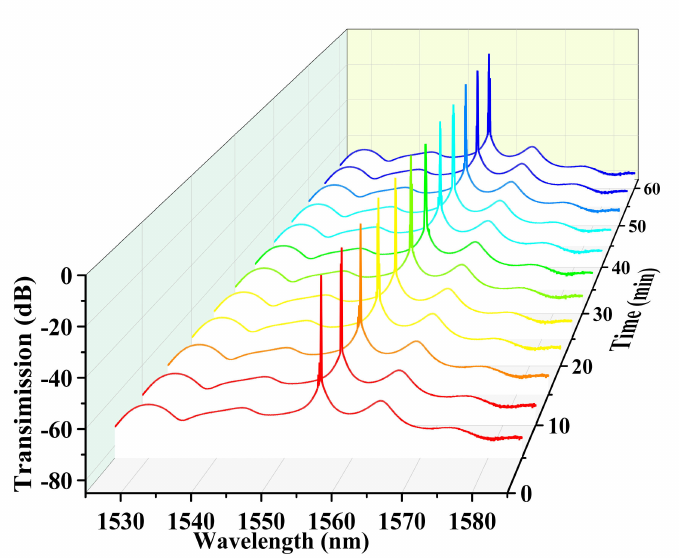
Figure 8. Stability test of the fiber ring laser of S1 at a constant temperature of 30 ◦